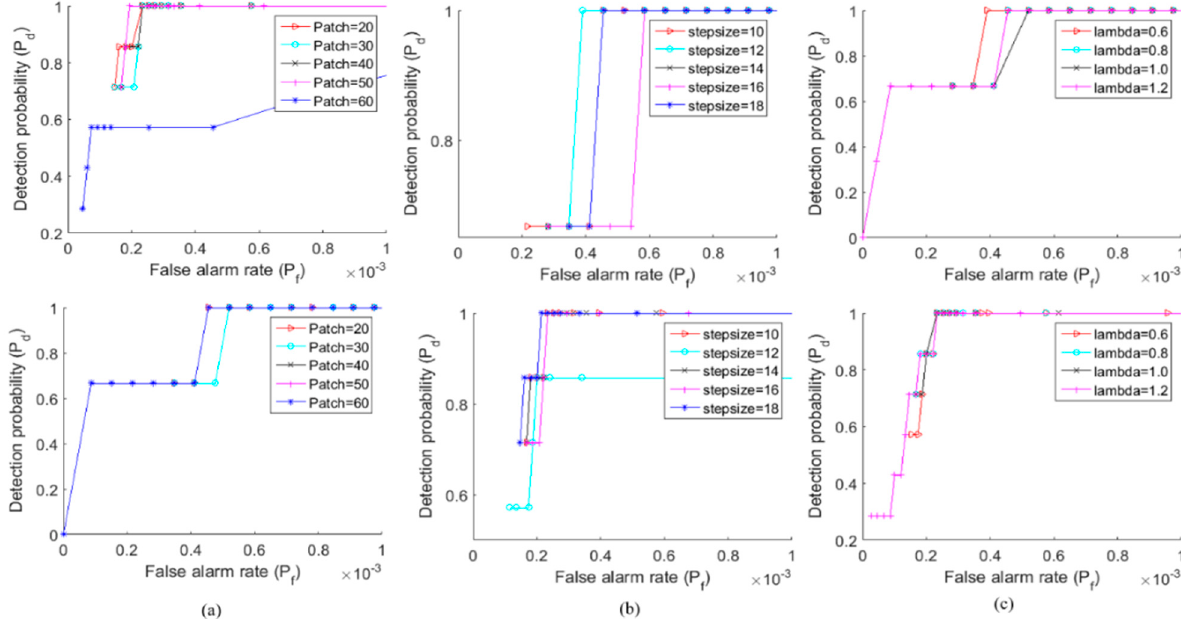
Figure 13. ROC curves of infrared sequence: ( a ) ROC curve of patch size for sequence; ( b ) ROC curve of step size for sequence; ( c ) ROC curve of controlling parameter for sequence .